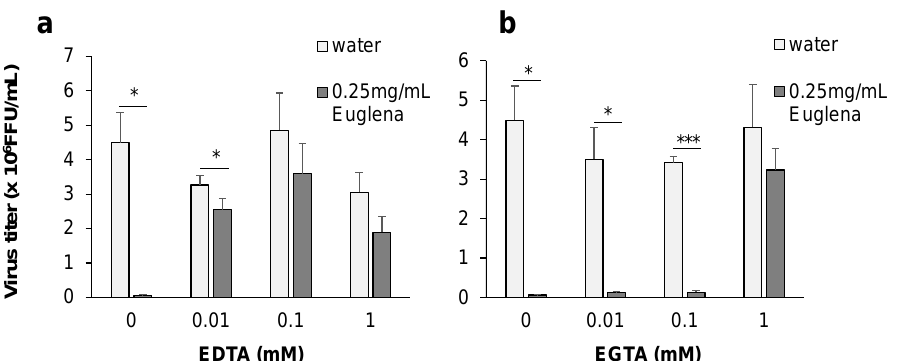
Figure 5. Determination of Euglena extract components involved in influenza virus growth inhibition. Madin–Darby canine kidney (MDCK) cells were cultured 24 h before virus infection with ( a ) EDTA-treated Euglena extract, ( b ) EGTA-treated Euglena extract. Cells were infected with virus after exchanging medium, and then the virus titer was determined. Error bars indicate standard deviations ( n = 3). * p < 0.05, *** p < 0.001. FFU: focus-forming units. In this study, we tested the anti-influenza activity of zinc acetate, and confirmed its inhibitory effect on the growth of the influenza virus (Figure 6a). The IC 50 of zinc acetate was 57.65 ± 10.27 nM. Using CER, we compared the antiviral activity of Euglena extract from which metal ions were removed, with and without zinc acetate. The sample with zinc acetate showed the same antiviral activity as Euglena extract itself (Figure 6b). The respective zinc concentrations are shown in Table 2. Thus, zinc is considered one of the extract. Table 2. Zinc concentration in each Euglena extract. CER, cation exchange resin.